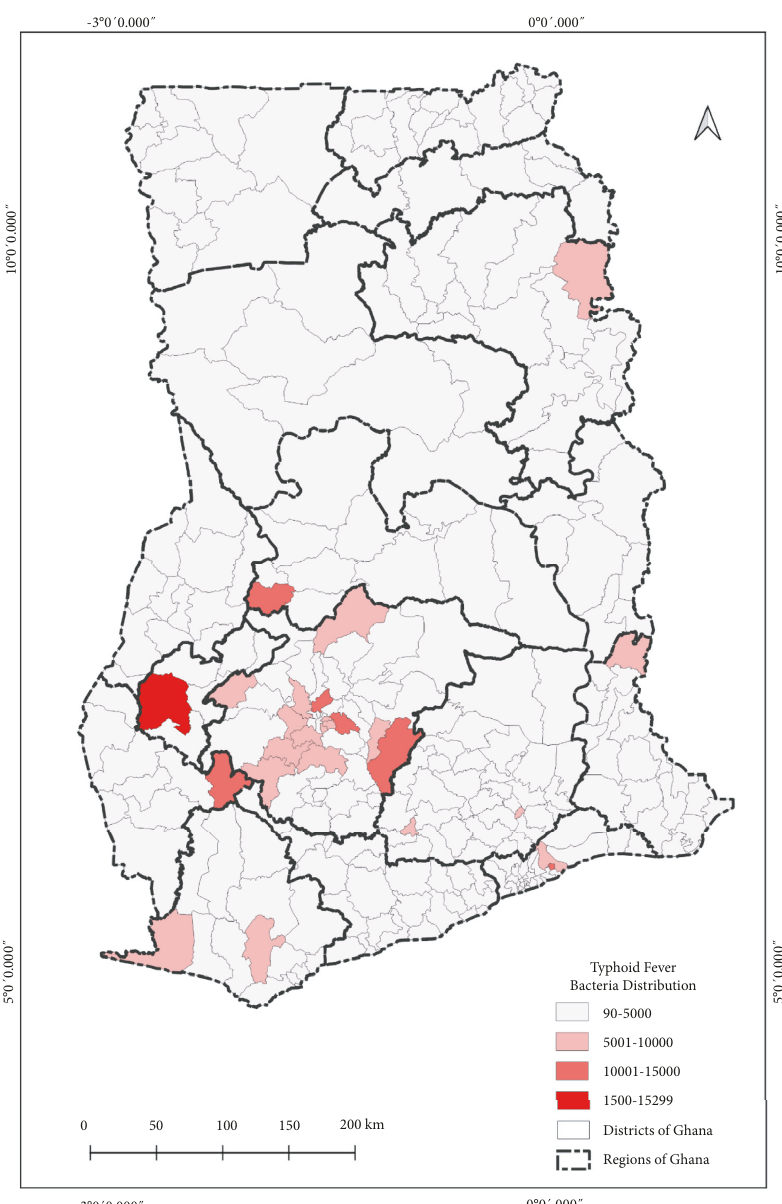
Figure 4: Distribution and intensity of typhoid fever bacteria pathogen in Ghana for the year 2020. The legend indicates the sum of typhoid fever cases recorded from health facilities in each district across the country. For instance, 90 was the least number of cases recorded from a district and 15,299 was the highest number of cases recorded from a district within the period of January to December 2020. The intensity classifications were generated based on quantile to assign the same number of data values to each class from the ArcGIS software used to develop the